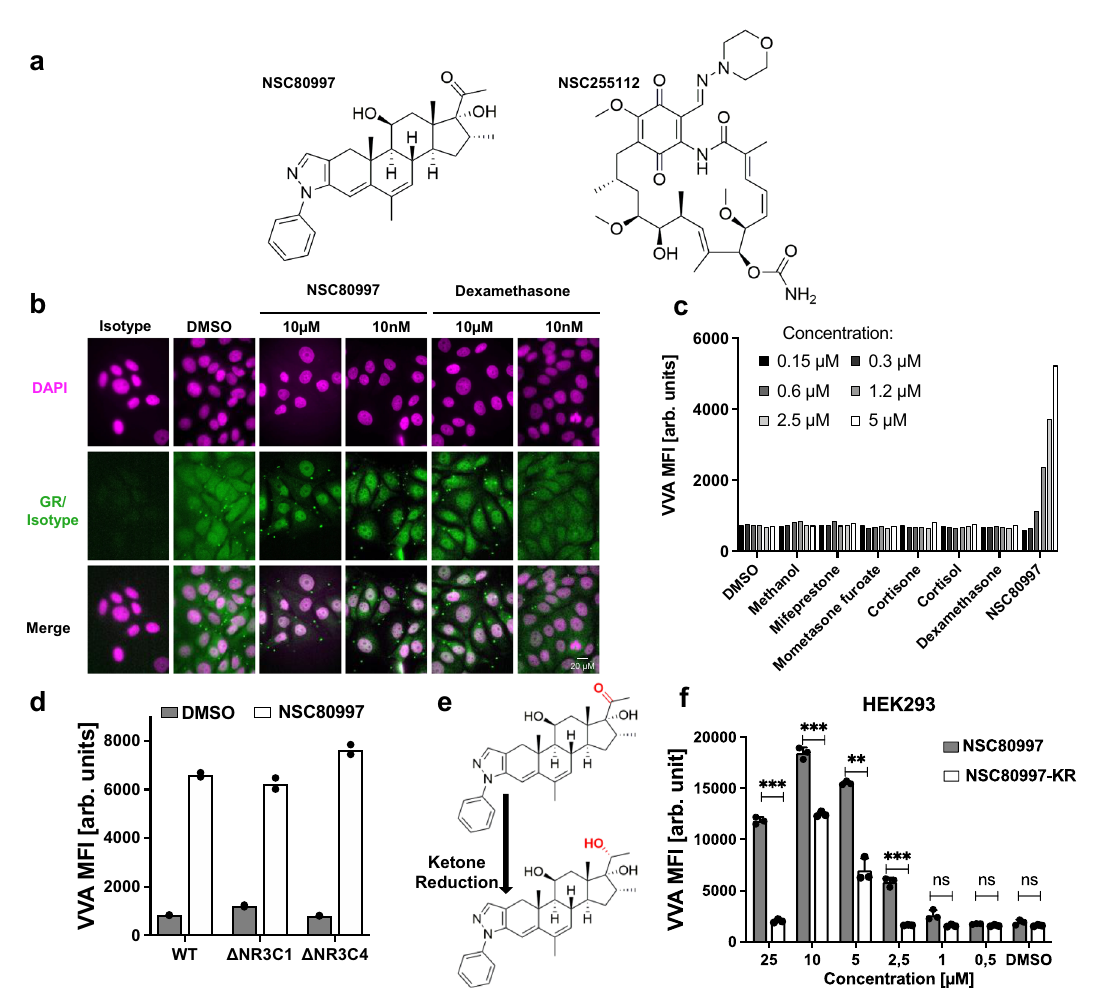
Fig. 3 | Remodeling ofglycosylation by leadcompounds isindependent ofthe glucocorticoidreceptor(GR).a ChemicalstructureofNSC80997andNSC255112. b Representative images of MCF7 WT cells treated with DMSO, 10 µ M or 10nm NSC80997 or dexamethasone for 24h, stained with isotype or anti-GR antibody (green) and DAPI (magenta). Scale bar represents 20 µ m. c Bar diagram shows cell surface VVA binding to HEK293 WT cells treated for 24h with increasing con- centrations of mifepristone, mometasone furoate, cortisone, cortisol, dex- amethasone, or NSC80997. DMSO and methanol served as controls. Data was assessed by fl ow cytometry, is presented as mean fl uorescence intensity (MFI) (arbitrary units) and is representative of two independent